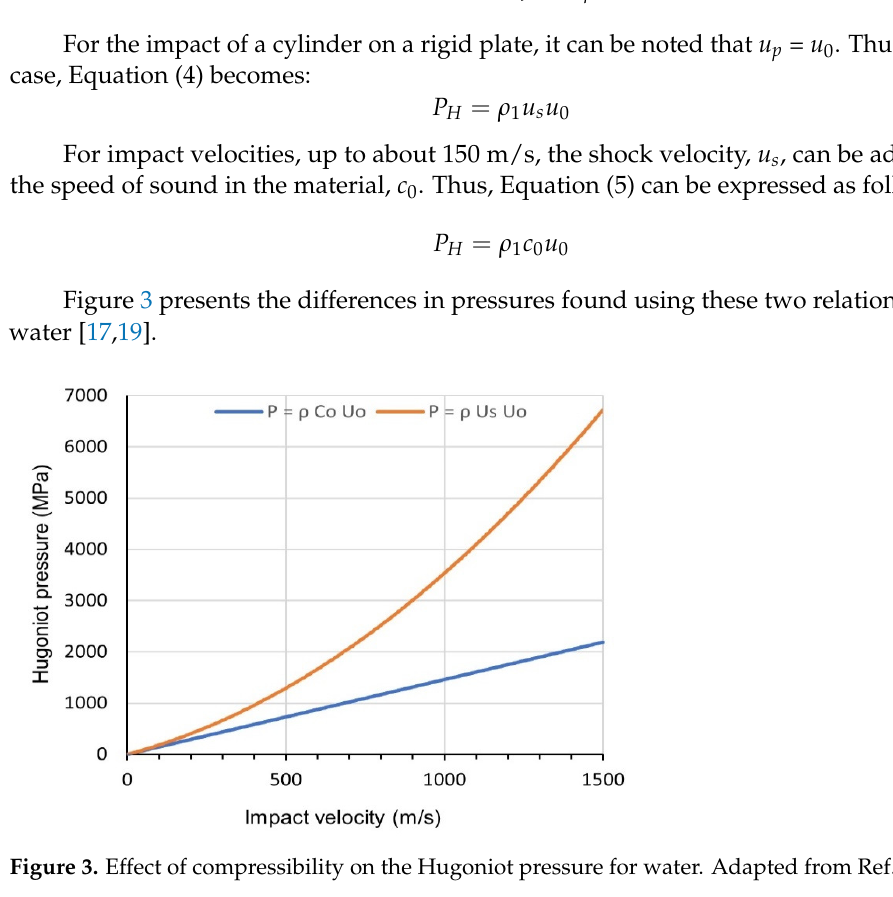
Figure 2. Hugoniot and steady flow pressure profile. Adapted from Ref. [25].